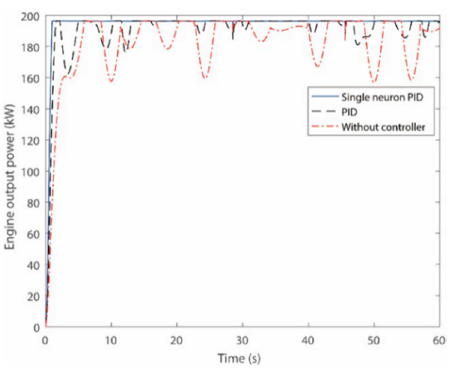
Figure 7. The engine output power curves.